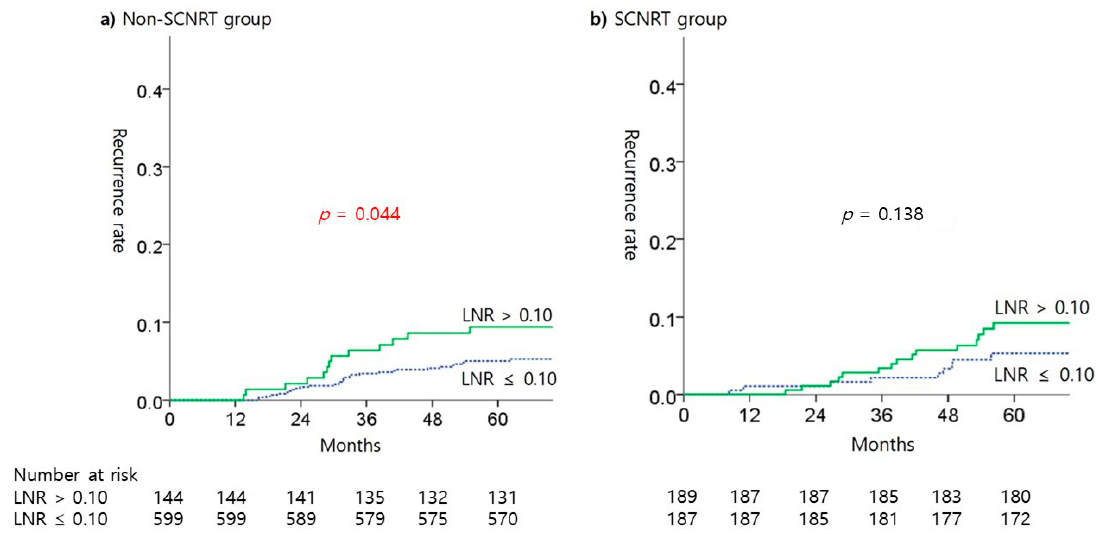
Figure 1. Kaplan-Meier estimates of recurrent rate according to LNR in SCNRT treatment Figure 1. Kaplan ‐ Meier estimates of recurrent rate according to LNR in SCNRT treatment subgroups.